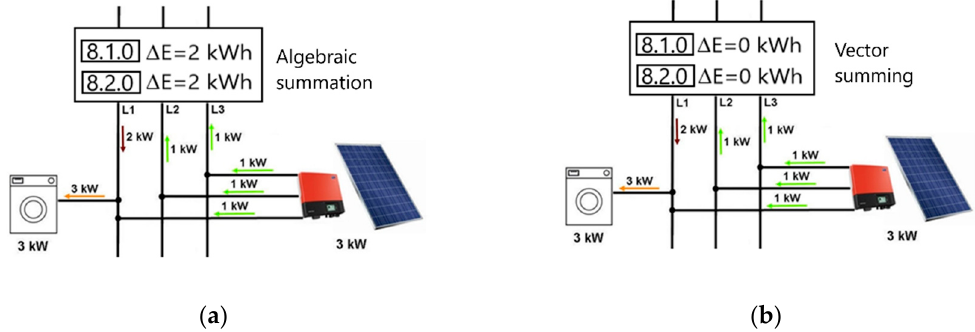
Figure 2. Differences in registers of three-phase energy meters for mode: ( a ) algebraic summation, ( b ) vector summation for an example generation and a load.